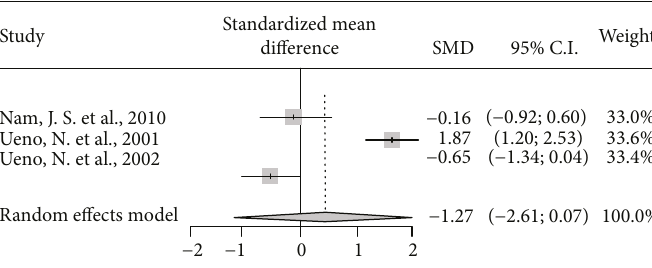
Figure 4: The results of the meta-analysis for fasting insulin.